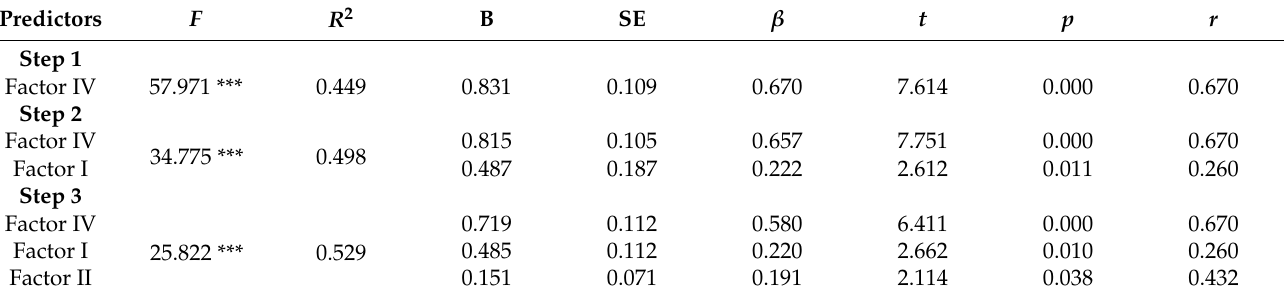
Table 9. Multiple linear regression model for pedagogical training for